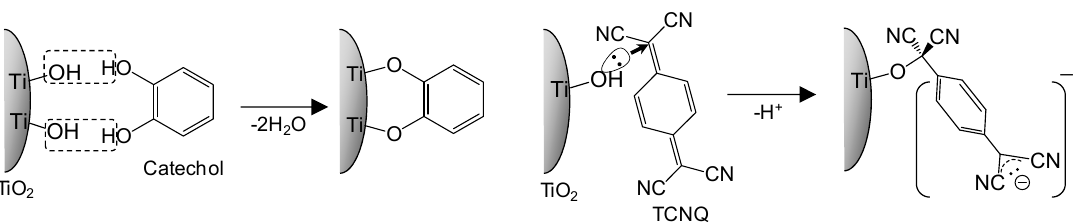
Figure 3. Chemisorption reactions of ( a ) organic compounds bearing proton-donating chemical anchoring groups via dehydration condensation reaction and ( b ) TCNQ via nucleophilic addition reaction.